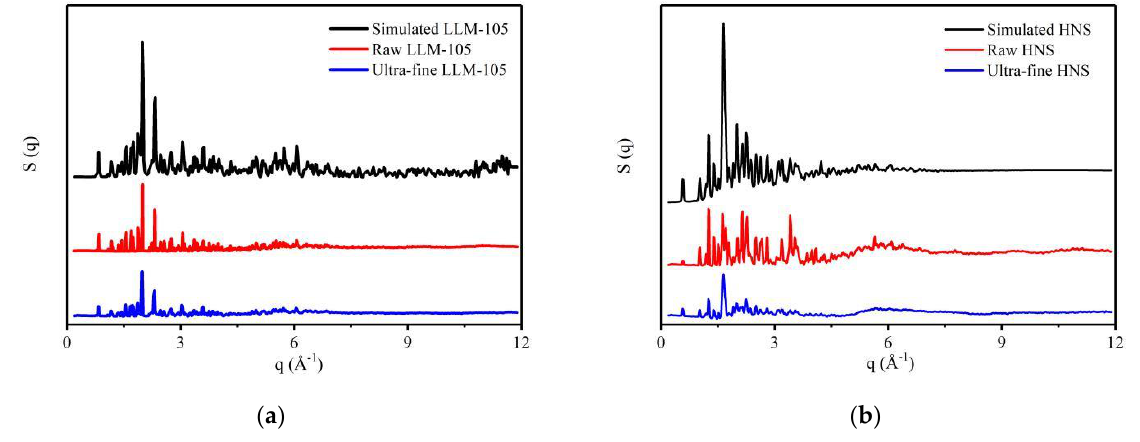
Figure 3. Structure factors of explosives with different particle sizes: ( a ) LLM-105; ( b ) HNS.